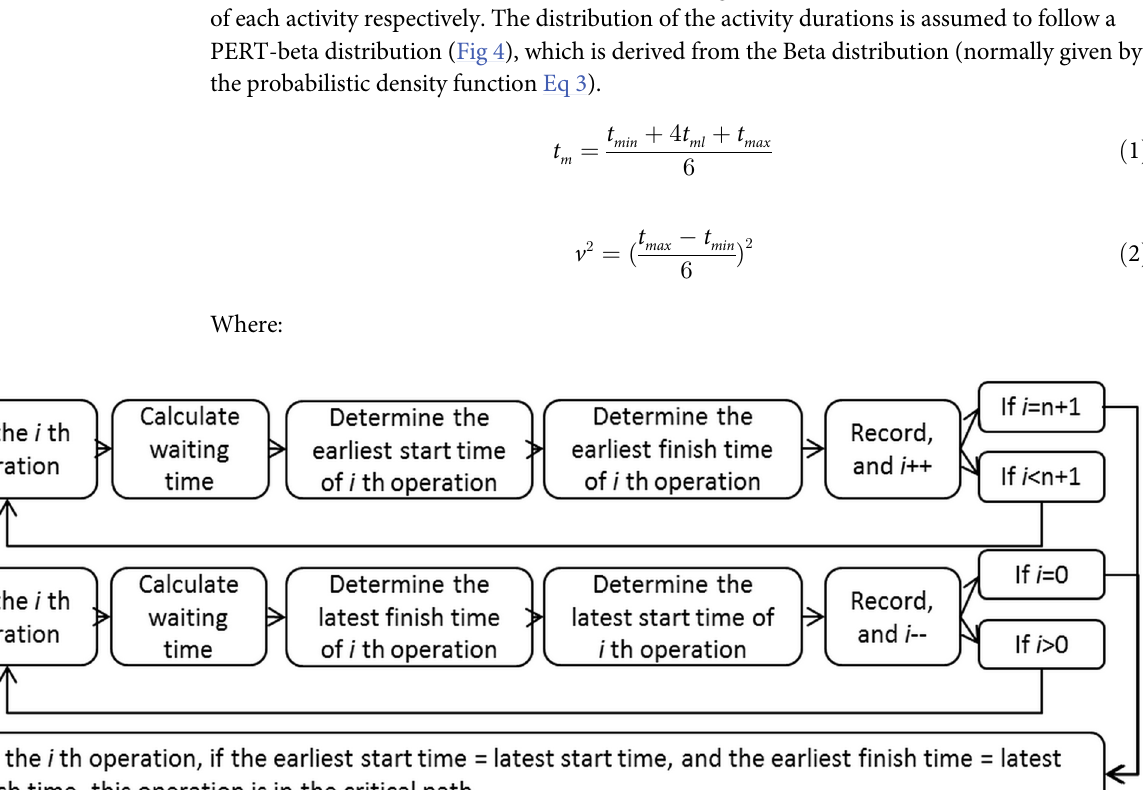
PLOS ONE | DOI:10.1371/journal.pone.0129572 June 10,